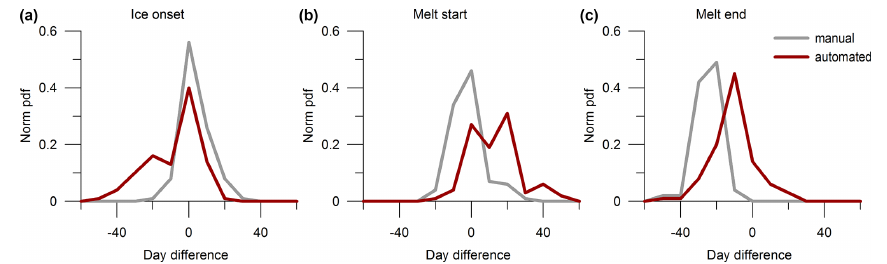
Figure 7. Normalised probability density function (norm pdf) of difference in number of days between altimetric and in situ observed dates of (a) ice onset, (b) melt start and (c) melt end over the 2008–2019 period retrieved for 10 virtual stations from a training set of VSs using manual and automated